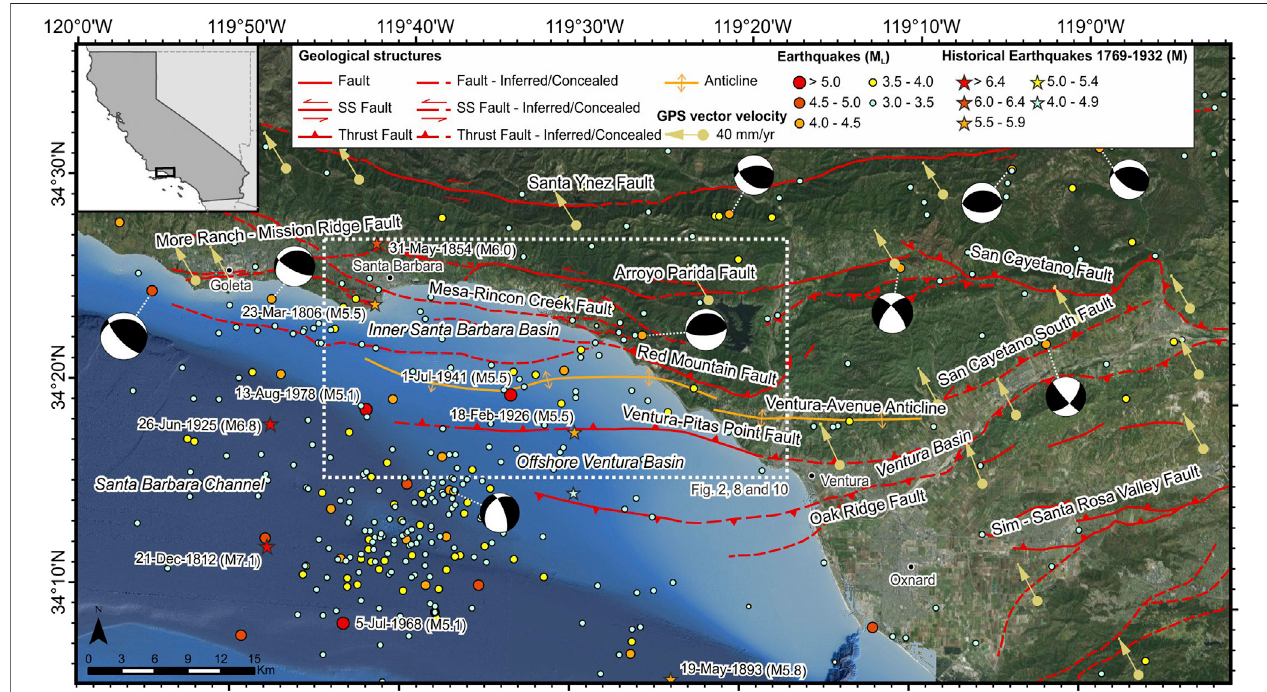
FIGURE 1 | Map of the Western Transverse Ranges showing the main active faults in the area (Jennings and Bryant, 2010), the California historical earthquakes between 1769 and 2000 (Toppozada et al., 2002), the instrumental seismicity between 1933 and 2017 (Hutton et al., 2010), the focal mechanism of earthquakes with magnitude ≥ 4.0 (information from the Southern California Earthquake Data Center: https://service.scedc.caltech.edu/eq-catalogs/CMTsearch.php; accessed April 2021) and the GPS vector velocities with respect to stable North America (information from UNAVCO: https://www.unavco.org/data/gps-gnss/derived-products/ derived-products.html;accessedApril2021).ThewhitedottedrectangleshowsthelocationofthestudyareaandtheInnerSantaBarabaraandOffshoreVenturabasins are labelled. Inset shows the regional location of the Western Transverse Ranges in California, USA.